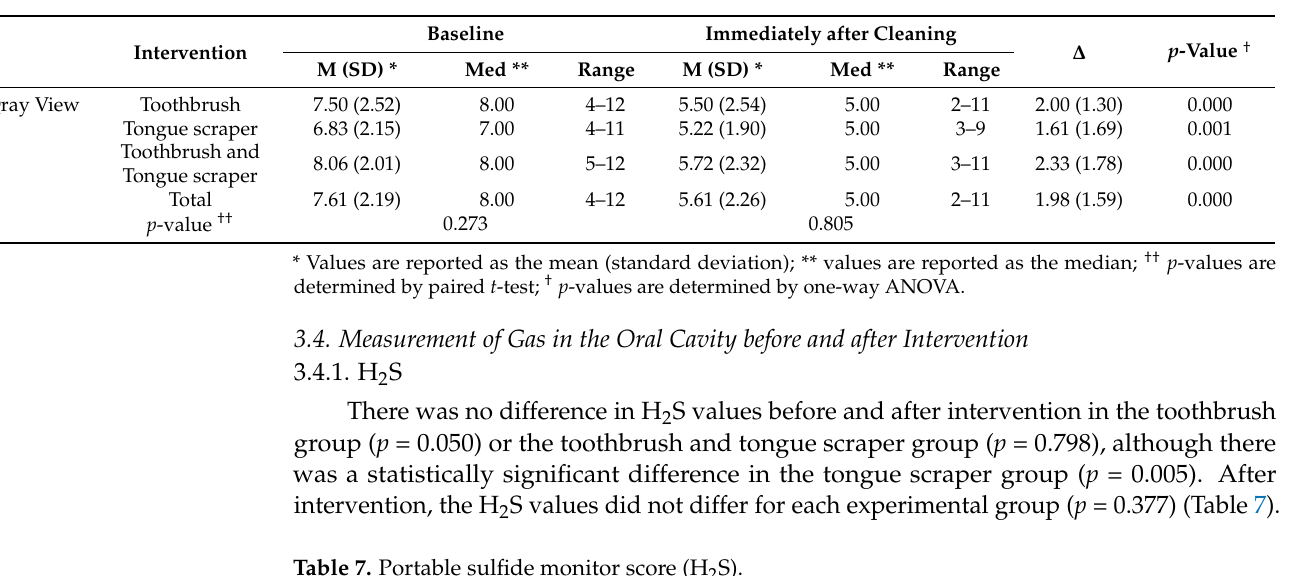
Table 6. Tongue coating score (Qray view).